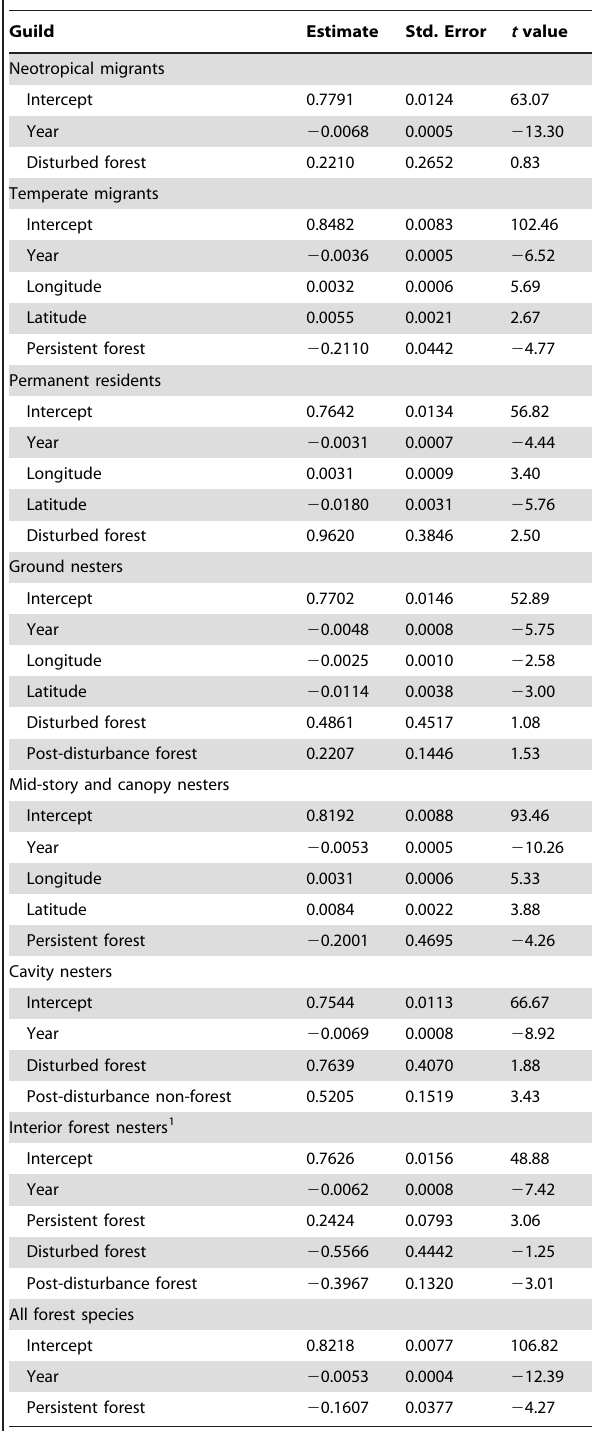
Table 3. Parameter estimates, standard errors, and t values for attributes of the 1200 km 2 circular landscape surrounding Breeding Bird Survey routes that affect progressive community similarity of forest